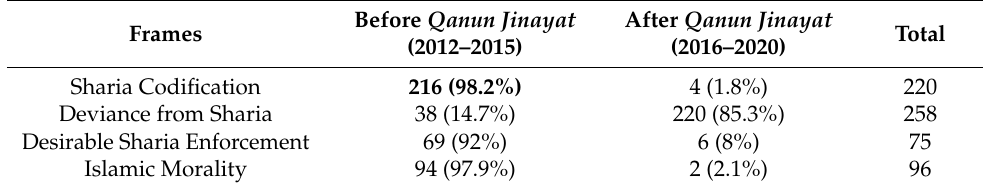
Table 6. The use of frames by time period.